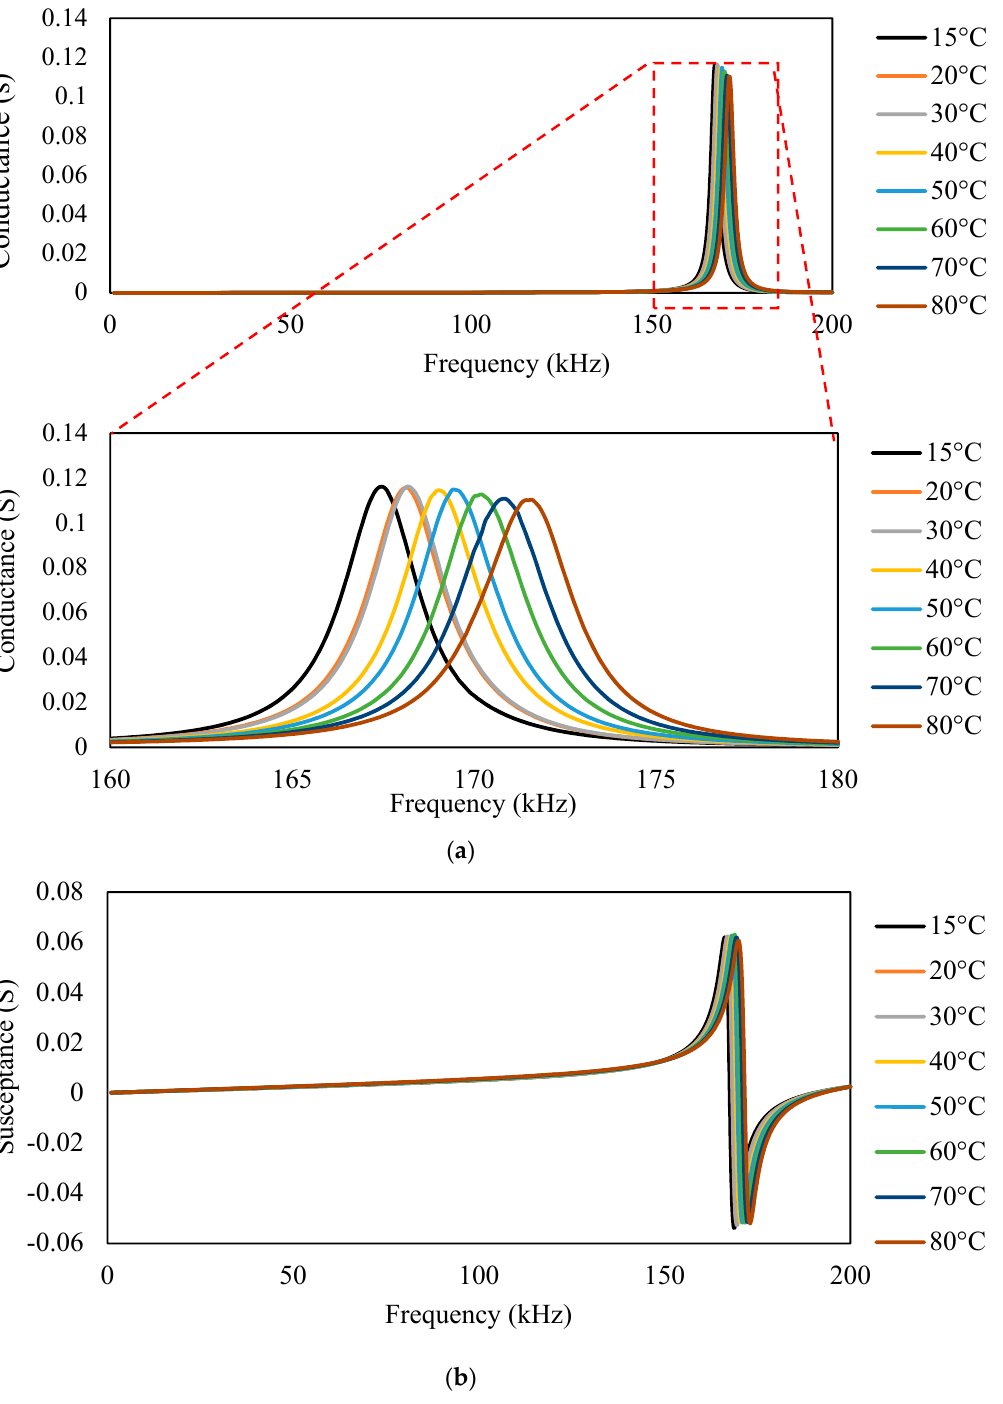
Figure 7. Free PZT sensor signatures at different temperatures: ( a ) conductance, ( b ) susceptance. The vertical shift in the signature with the temperature variation is shown in Figure 8. The shift in the first natural frequency with respect to temperature has a linear distri- bution in horizontal and vertical shifts.